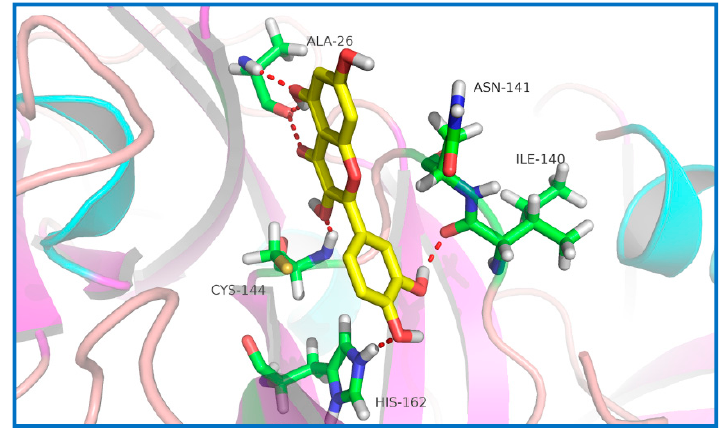
Figure 6. Docking of quercetin with PEDV 3C-like protease (3CL pro ). Quercetin and amino acid residues contacting quercetin are represented as sticks. Quercetin and amino acid residues are colored according to different atom types. Moreover, along with the bond distance, hydrogen bond interactions are shown as red dashed lines between the respective donor and acceptor atoms.